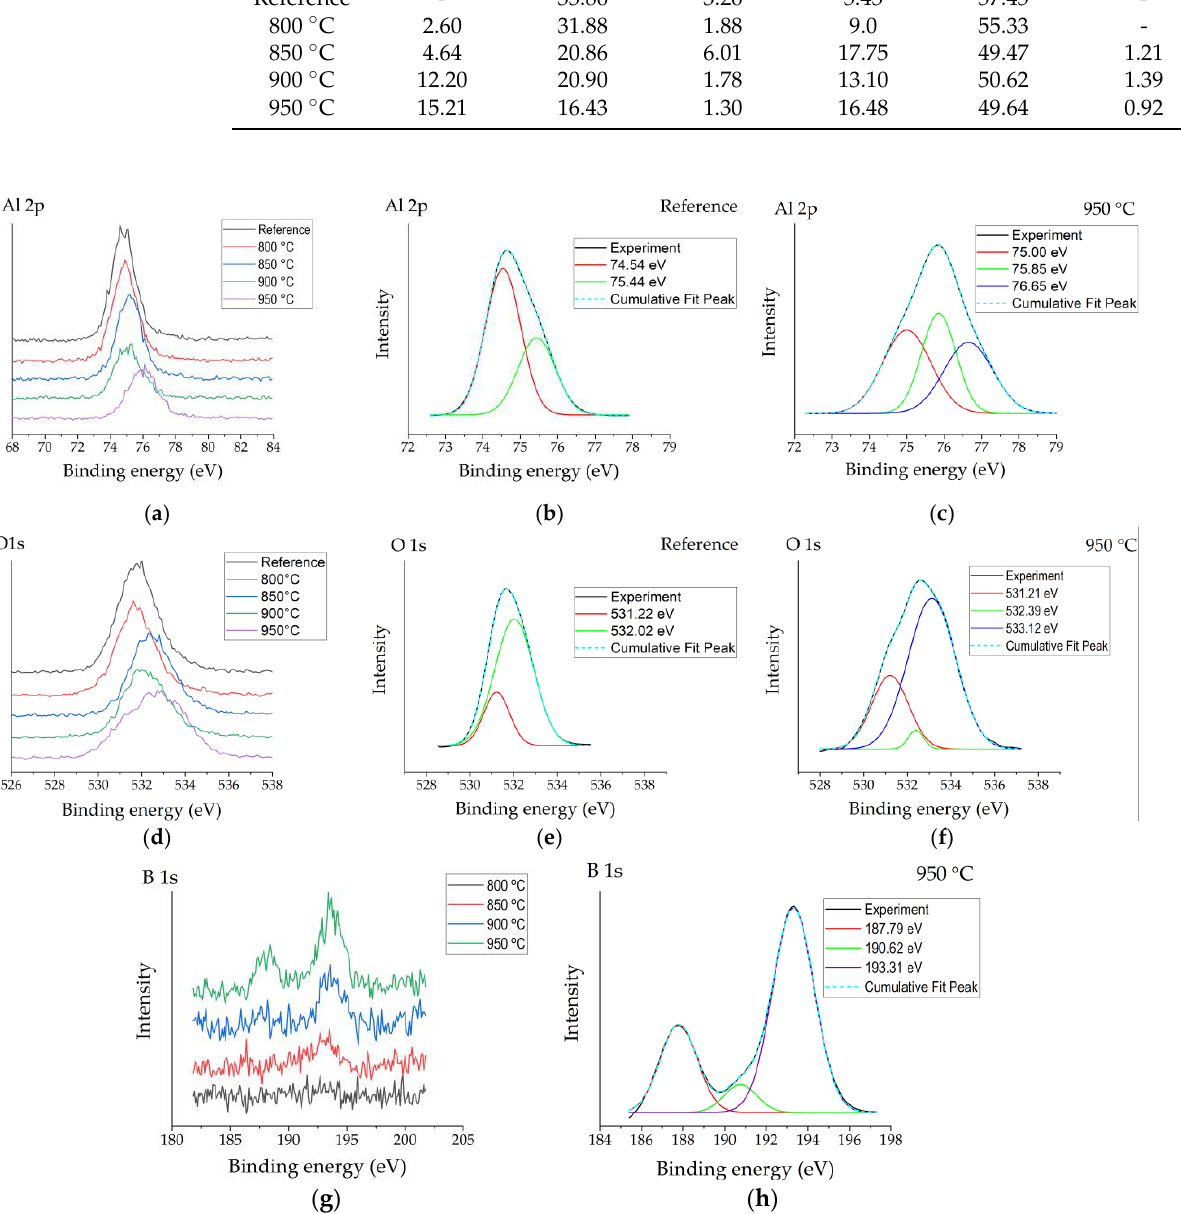
Figure 3. XPS spectra patterns of the reference sample (R) and boronized samples: ( a ) high-resolu- tion Al2p spectra measured for the reference and boronized samples; ( b ) and ( c ) deconvoluted Al2p spectra for reference sample and sample boronized at 950 °C, respectively; ( d ) high-resolution O1s spectra measured for the reference and boronized samples; ( e ) and ( f ) deconvoluted O1s spectra for reference sample and sample boronized at 950 °C, respectively; ( g ) high-resolution B1s spectra measured for the reference and boronized samples; ( h ) deconvoluted O1s spectra for sample bo- ronized at 950 °C. In their study, Ogugua et al. [19] investigated an iron-doped ZnAl 2 O 4 system and determined Al2p peak’s shift to higher binding energies with the increase of iron concen- tration. The authors assigned the appearance of Al2p peak components at 76.0 eV and 76.1 eV to Al – O – Fe. The authors related the appearance of the peak assigned to Al – O – Fe at a higher binding energy than that of peaks assigned to Al – O and Al – OH with higher elec- tronegativity of Fe (1.83) than Al (1.61). Taking into account that the electronegativity of boron is even higher (2.0), the appearance of the Al – O – B peak component at higher bind- ing energies looks to be reasonable. O1s peaks of boronized surfaces were also shifted to higher binding energies as compared with the reference (Figure 3d). For the non-modified Al 2 O 3 surface, two peaks’ components were observed after deconvolution (Figure 3e) — the peak at ~531.2 eV ascribed to O in Al 2 O 3 and the peak at ~532.0 eV typically assigned to OH − , chemisorbed oxygen or dissociated oxygen [17]. For boronized samples, one more peak at higher binding energy ~533.1 eV appeared (Figure 3f), which, according to [20], may be attributed to O – B bonds. The results of the analysis of B1s peaks were consistent with the studies presented above and confirmed them in general. All B1s spectra obtained have shown peaks centred at ~193.3 eV (Figure 3g), attributable to B – O [20]. For more intensive spectra obtained at surfaces boronized at 900 – 950 °C, a peak centred at ~187.8 eV was observed, as well as a minor peak at ~190.6 eV (Figure 3h), which, based on the results reported earlier [19], may be assigned to B – O – Al bonds. The peak at 187.8 eV here should most likely be attributed to elemental boron from amorphous boron residues on the surface. 3.2. Adhesion of Ni-Based To evaluate the possibility to improve the adhesion between the alumina ceramic and metal melt by the thermochemical boronizing, pure nickel and self-fluxing refusible Ni- based alloy Metco 12C were thermally sprayed onto the surface of reference alumina sam- ple, and the samples were boronized at different temperatures. As expected, neither a pure nickel layer nor nickel alloy layer were formed onto the reference surface. After deposition and cooling in air, the layers detached. Samples bo- ronized at 800 °C, 850 °C and 900 °C did not show an improvement in metal adhesion to alumina. As a result of boronizing, aluminium borate formed on the surface, known as a quite inert material. Therefore, such result of the metal deposition experiment was pre- dictable as well. However, the metal layers and individual splats adhered to the surface of samples boronized at 950 °C. Figure 4 shows the SEM micrographs of the samples cross